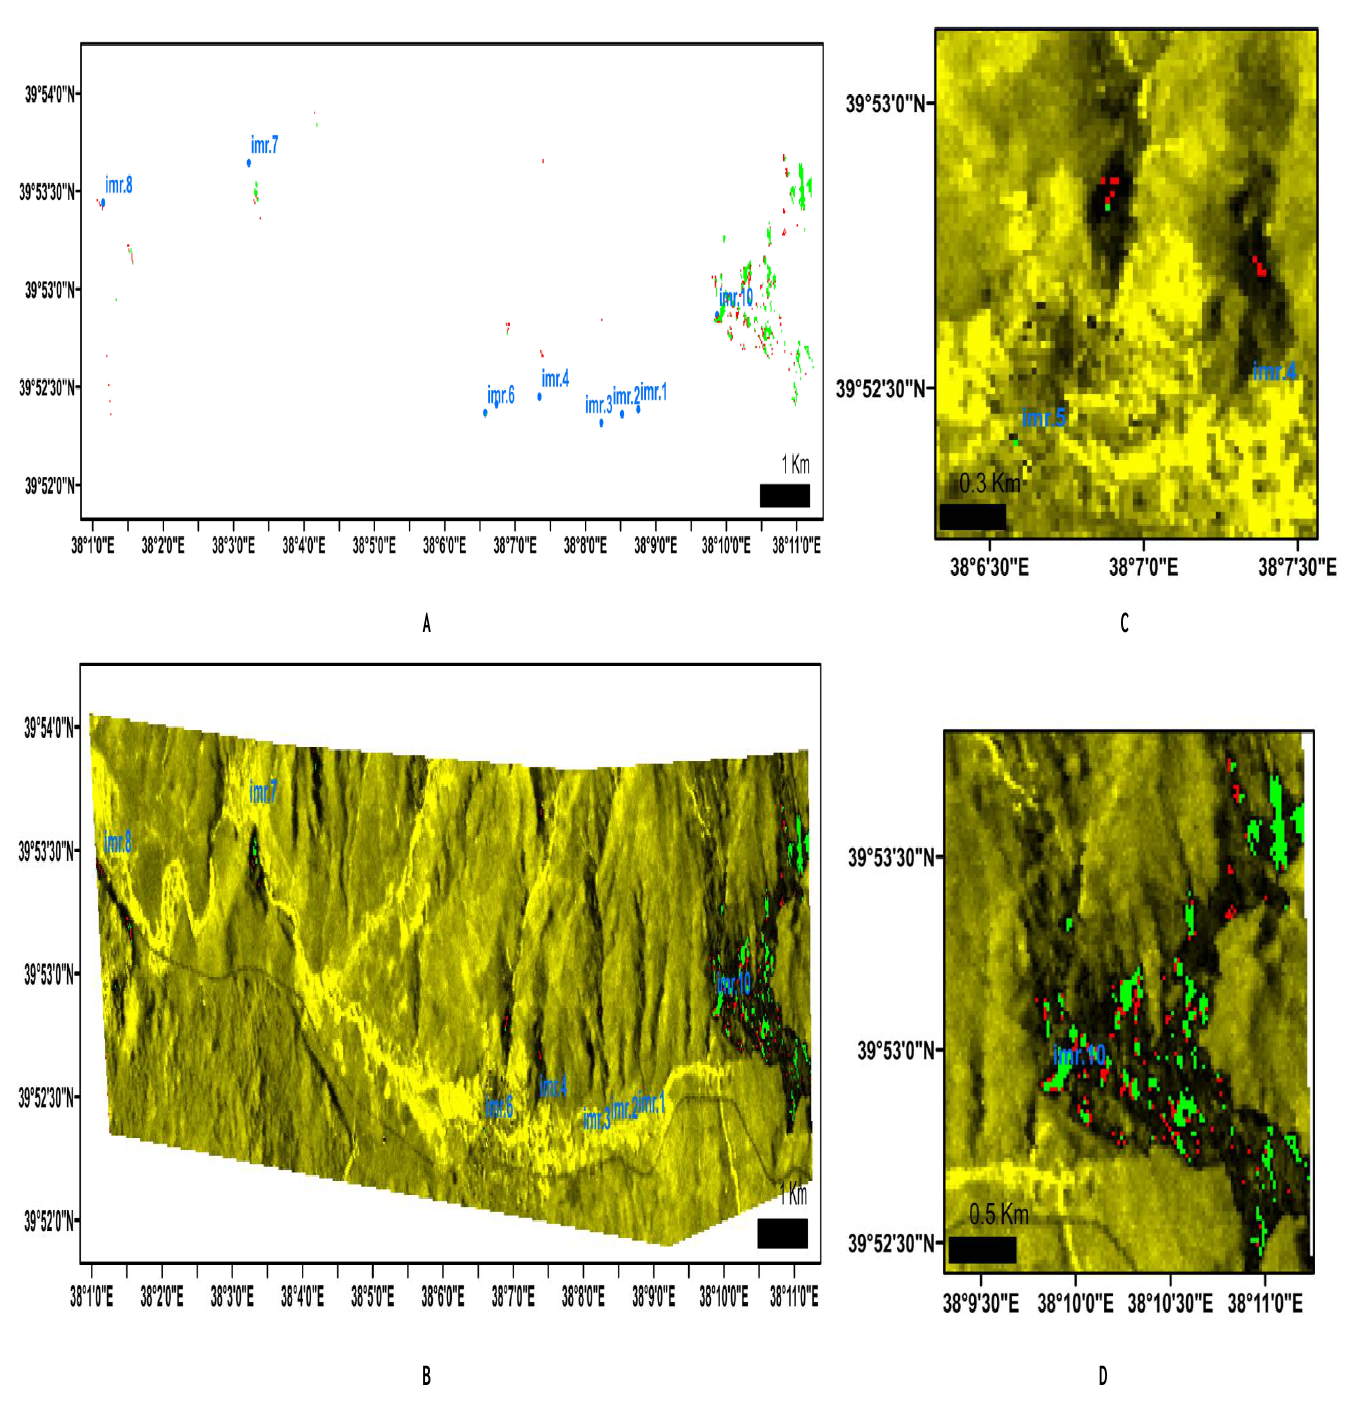
Figure 5: a-b) Classifcation of the study area, c) Classification of water resources feeding Imranli town, d) Classification of Imranli Dam (Red pixels are for Quality I, green pixels are for Quliaty